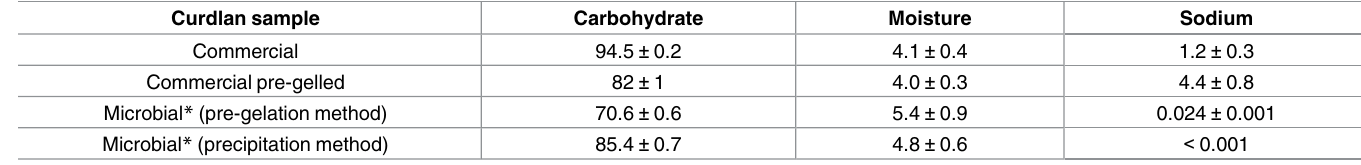
Table 1. Carbohydrate, moisture and sodium content (%) of different samples of curdlan. Valuesindicate mean ± standard-deviation. Curdlan